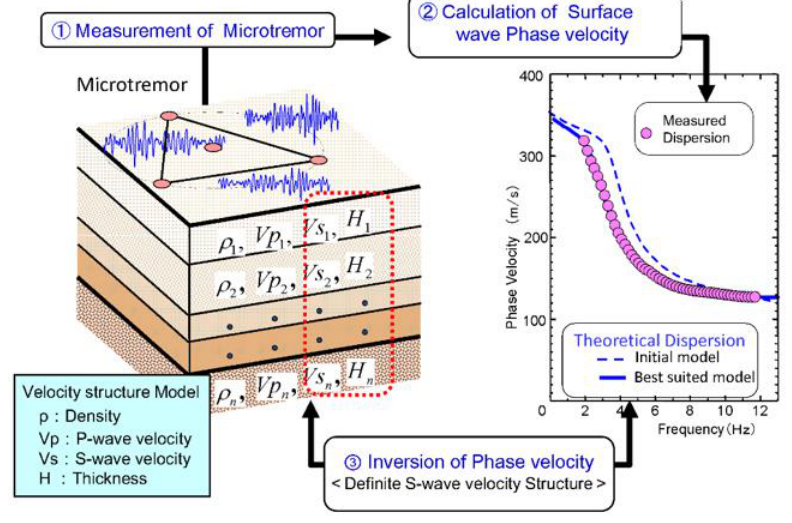
Figure 3. The general principle of the generated shear-wave velocity (Vs) data [17].